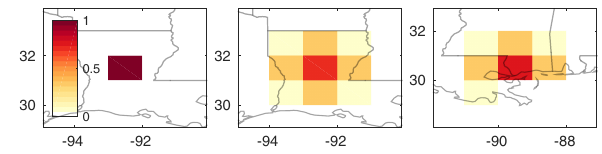
Figure 6. A selection of atoms from the dictionary used for the sparse dictionary reconstruction method. These atoms are scaled to represent the state vector via linear combination. The left and mid- dle elements are the basic shapes centered in each grid cell of the domain. At coasts and lakes these shapes are limited to land grids. All atoms are normalized in the 2-norm. The dictionary chosen here also holds a constant background